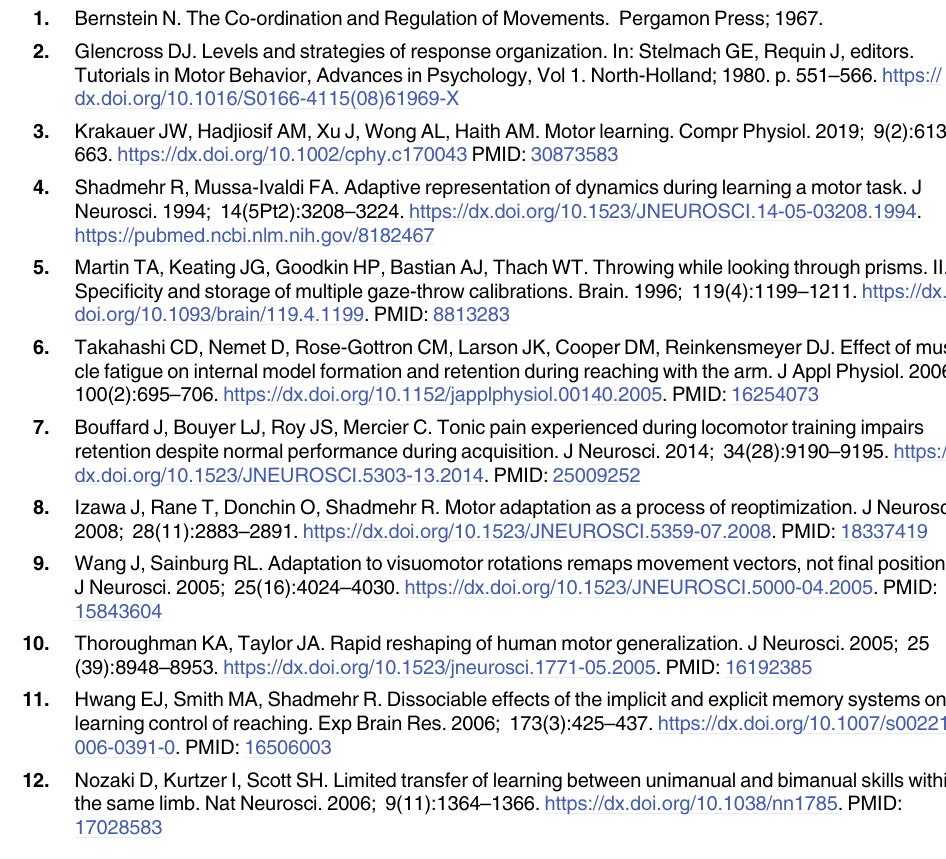
S10 Fig. Power spectrum analysis. A . Power spectrum density (arbitrary unit) of velocity average across trials and participants, for baseline ( black ), before-effect ( red ), adapted ( green ) and after-effect ( green ) trials. B . Same as A for acceleration. C . Same as A for jerk.